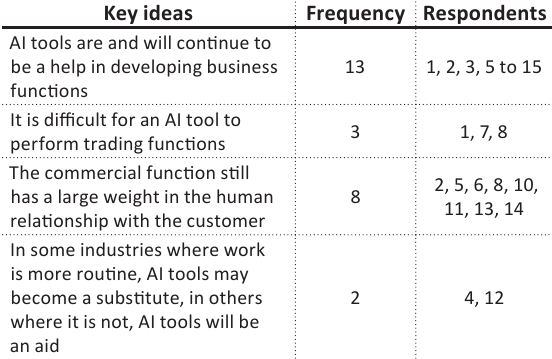
Table 2. Impact AI tools have on commercial work